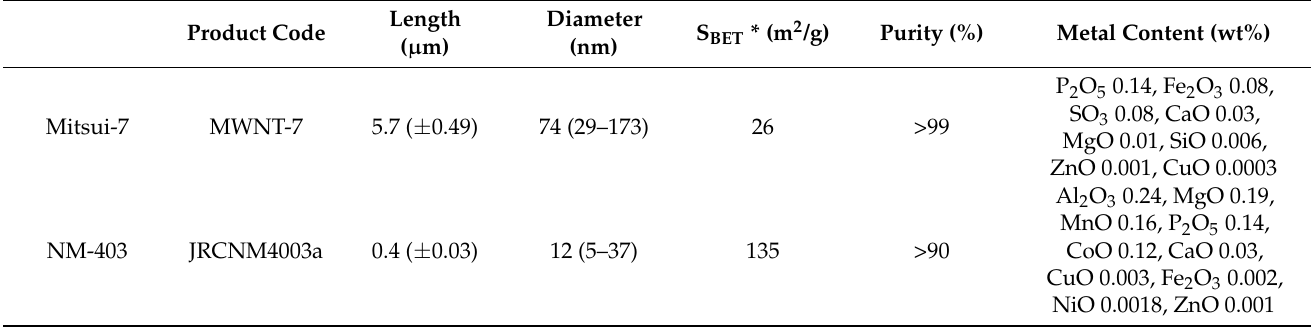
Table 1. Mitsui-7 and NM-403 characterization 1